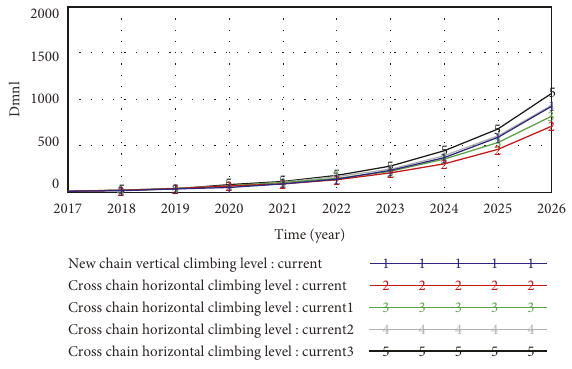
Figure 7: Sensitivity analysis of the market